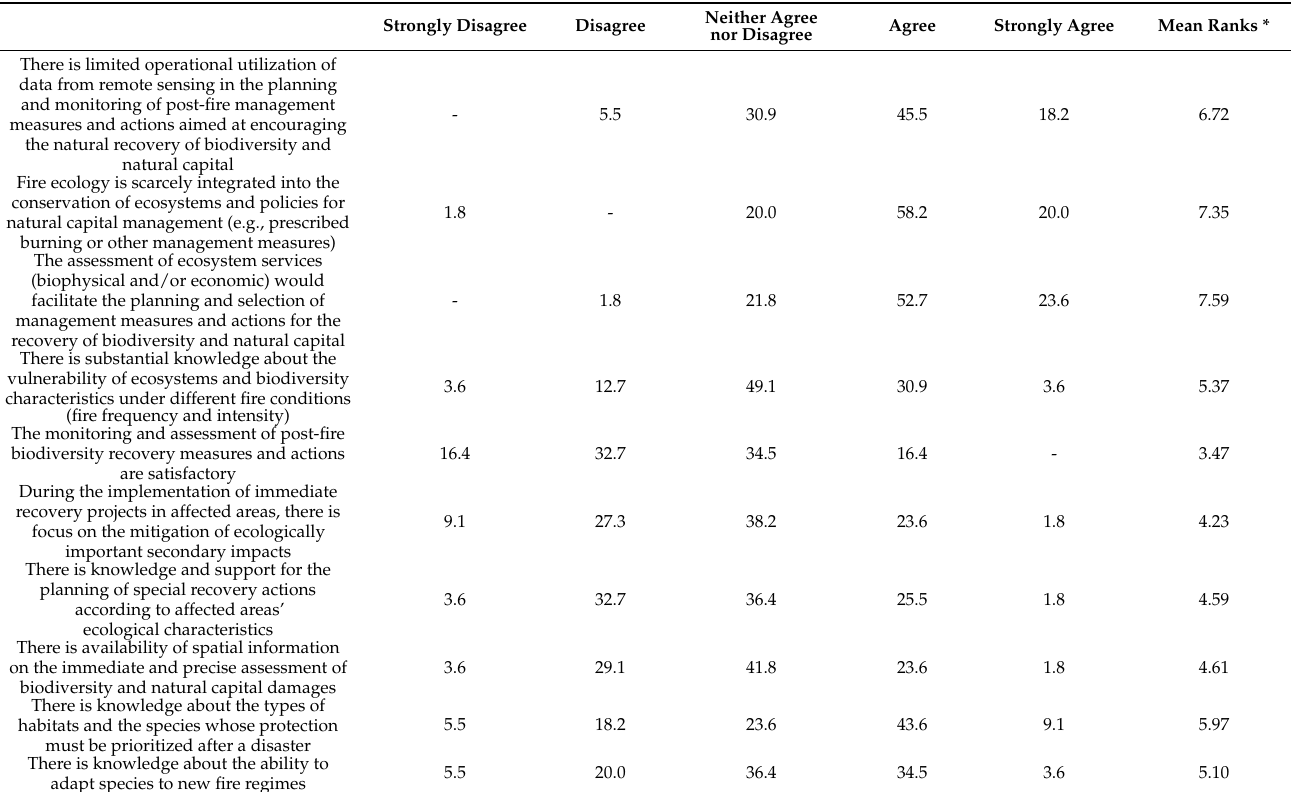
Table 7. Percentage units and differences among respondents’ agreement with statements ( N = 55).